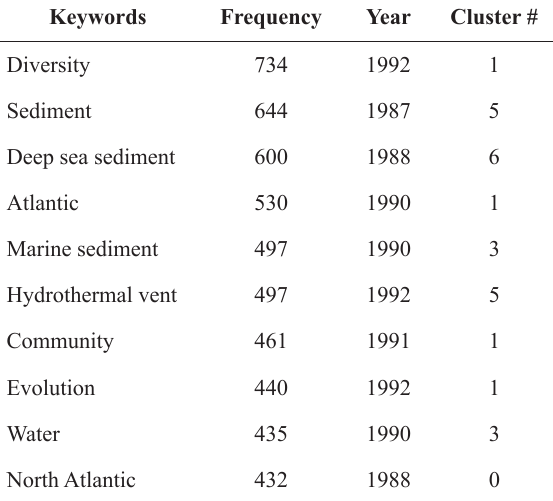
between 1987-2016, their frequency, the year of their first registration and the cluster to which the keywords belong.